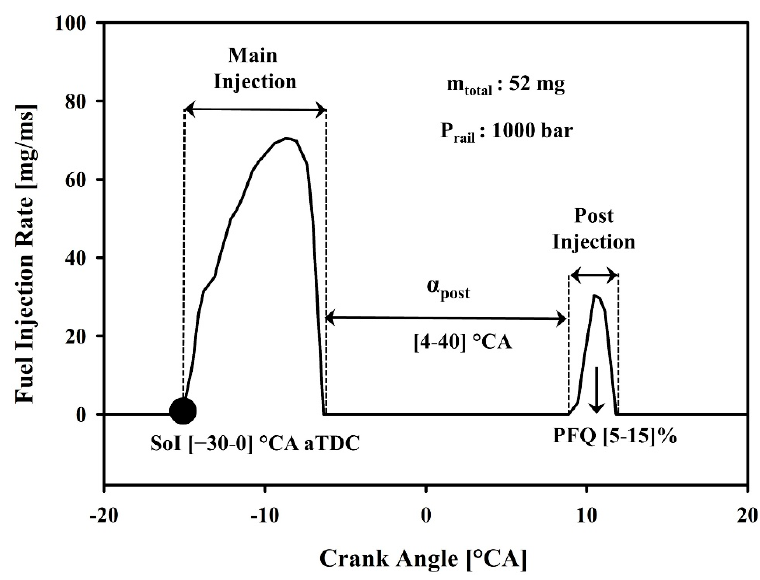
Figure 2. Post injection strategy .